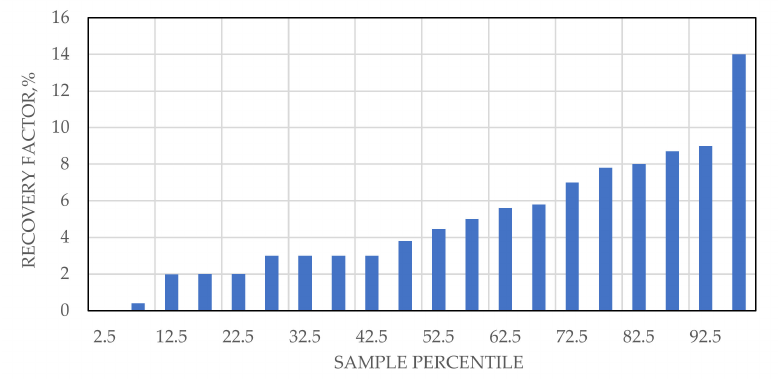
Figure 9. Normal distribution graph for tertiary